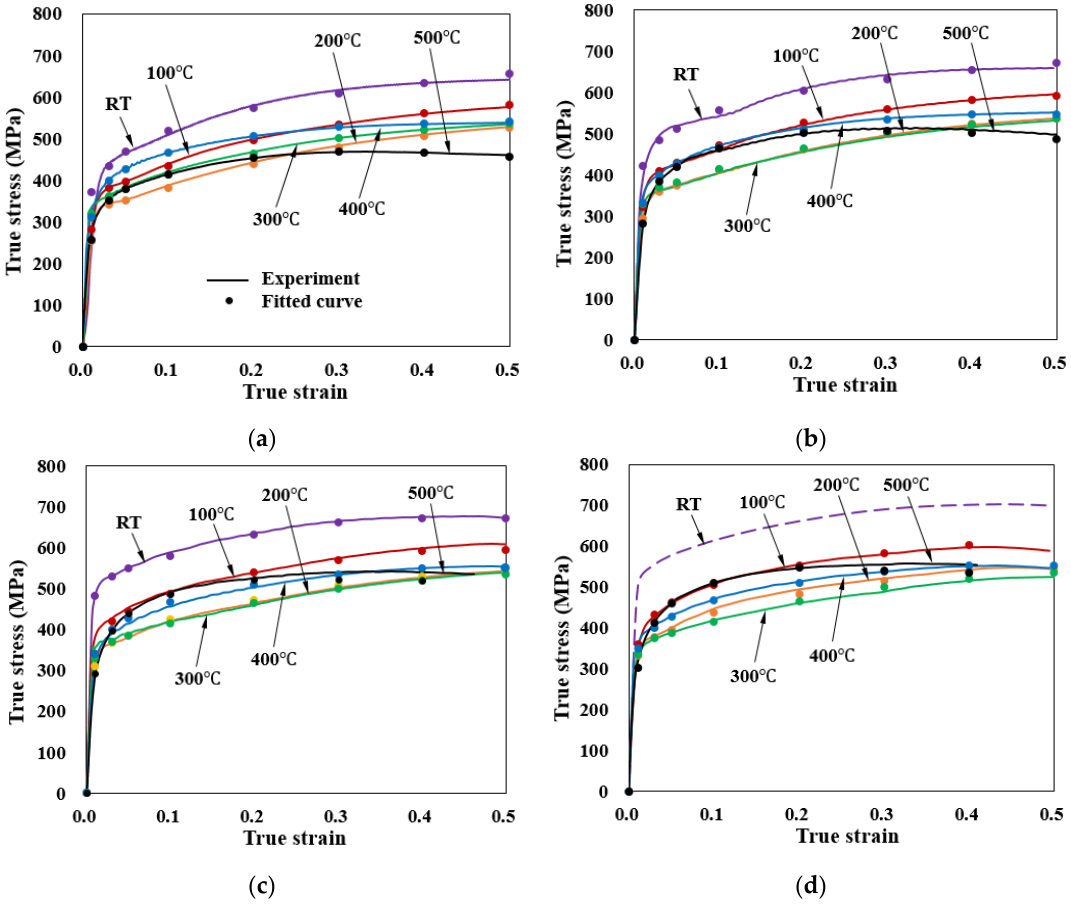
Figure 20. Experimental and fitted flow stresses with respect to strain and temperature, for various